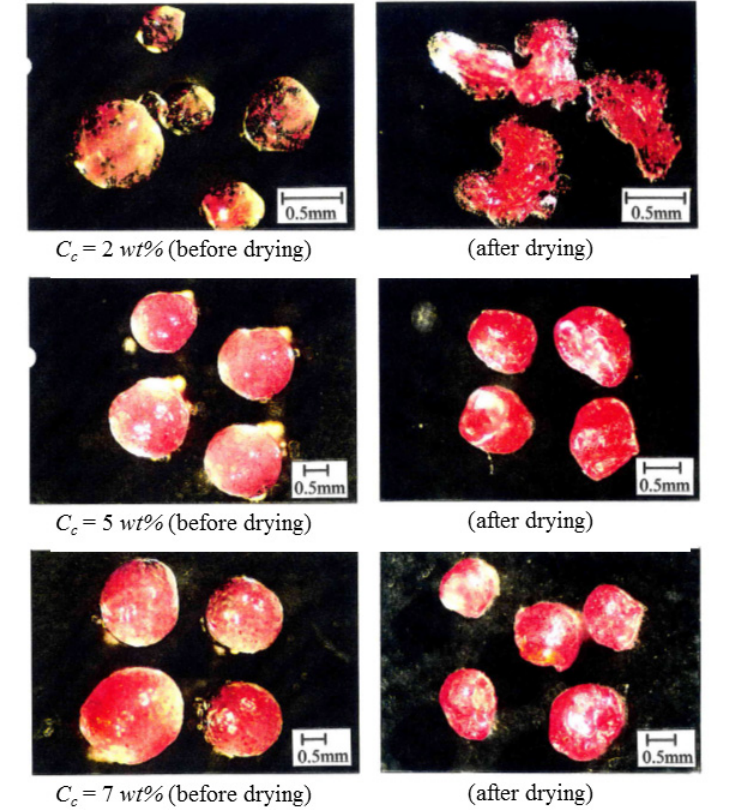
Figure 4. Observation of